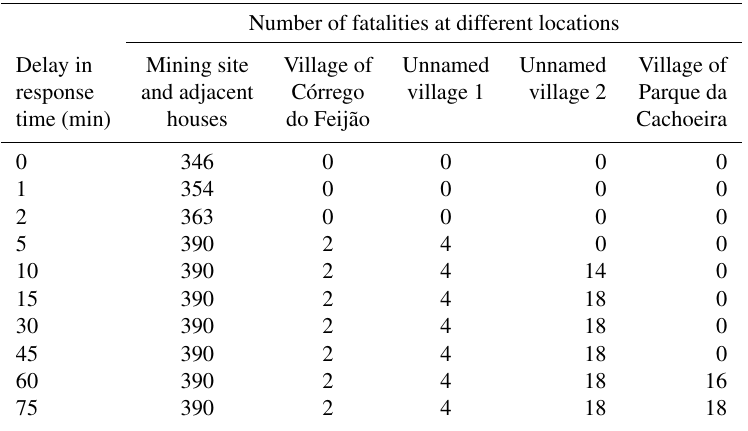
Table 4. Results of the Life Safety Model (LSM) showing how the delay in response time affects the number of fatalities downstream of the Brumadinho tailings dam assuming a warning is issued at the time of its failure. Number of fatalities at different locations Delay in Mining site Village of Village of response and adjacent Córrego village 1 do